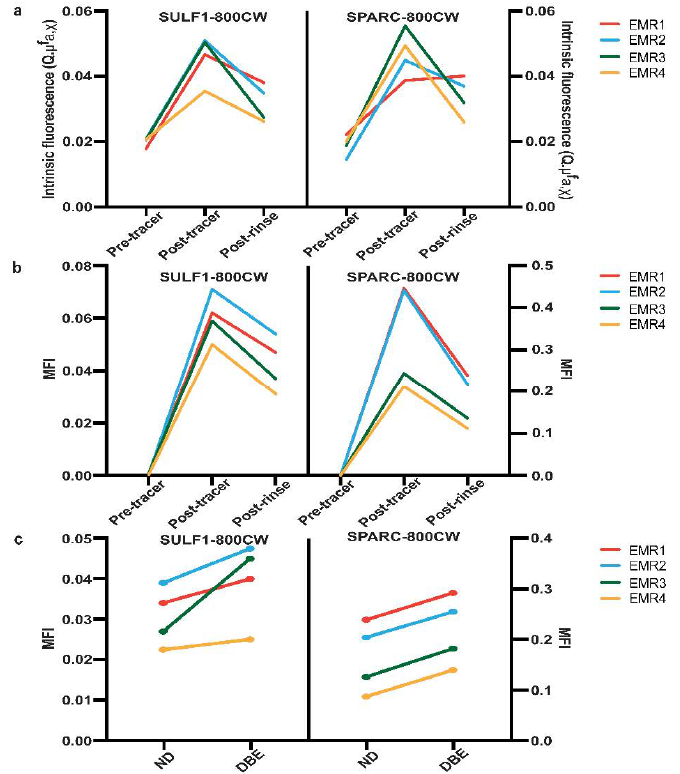
Figure 4. The fluorescence intensity analysis of SULF1-800CW and SPARC-800CW on EMR speci- mens. ( a ) The quantified intrinsic fluorescence with MDSFR/SFF spectroscopy of SULF1-800CW (left) and SPARC-800CW (right) before tracer spraying (pre-tracer), after tracer spraying, and before rinsing (post-tracer) and after rinsing (post-rinse). ( b ) The mean fluorescence intensity (MFI) of SULF1-800CW (left) and SPARC-800CW (right) before tracer spraying (pre-tracer), after tracer spraying before rinsing (post-tracer), after rinsing (post-rinse). ( c ) The MFI of dysplastic BE (DBE) tissue compared to non-dysplastic (ND) tissue. Each line connects paired data from the same spec- imen. DBE: dysplastic Barrett’s esophagus; EMR: endoscopic mucosal resection; MFI: mean fluores- cence intensity; NDBE: non-dysplastic Barrett’s esophagus.